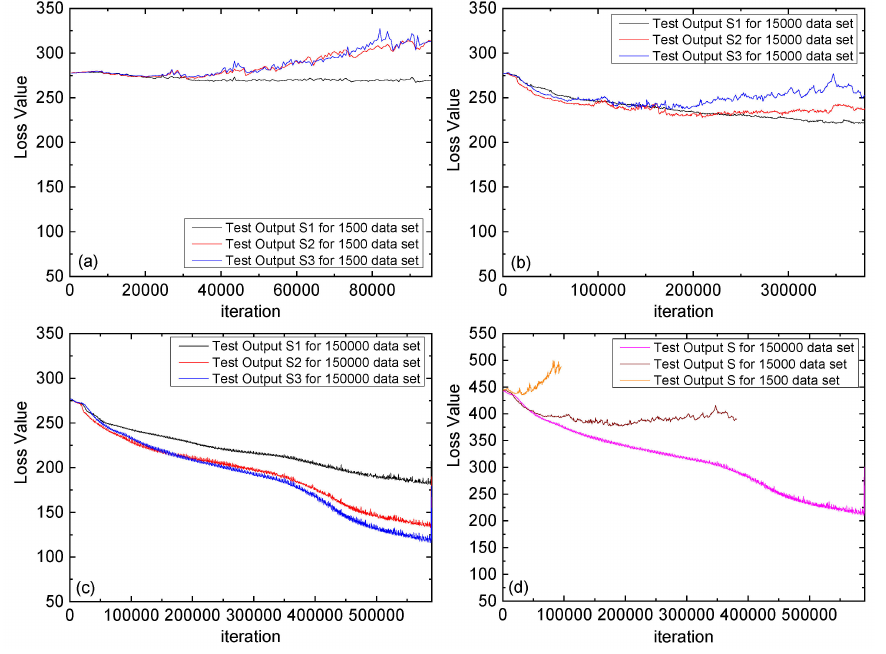
Figure 4. The loss value curve for the test process on the test data set of ( a ) 1500 ( b ) 15,000 and ( c ) 150,000. ( d ) The loss value curve comparison of the output result S for three test data